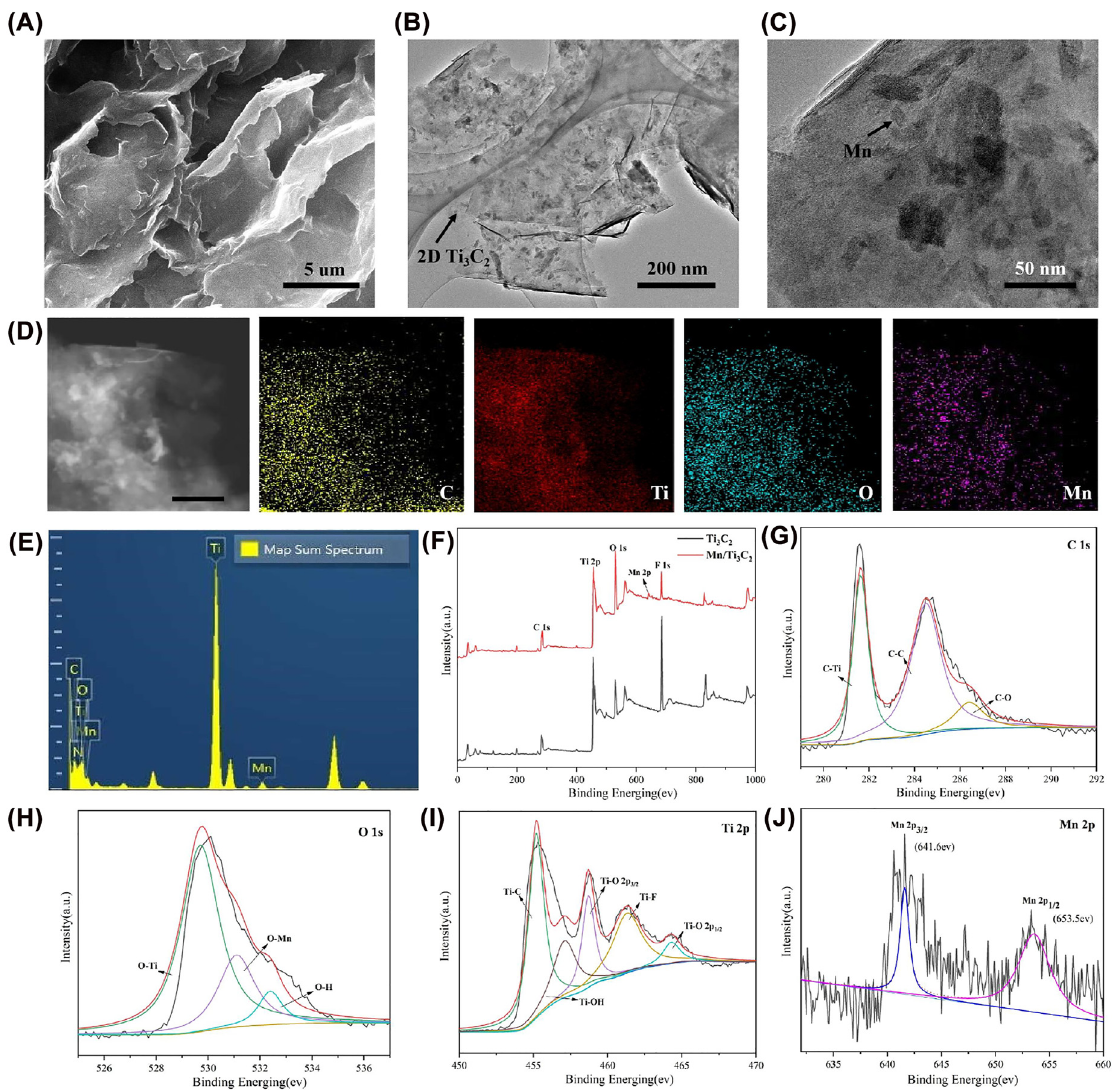
C nanosheets and Mn-Ti 3 2 C (D) HRTEM image of Mn-Ti 3 2 C (F) XPS full spectrums of Ti 3 2